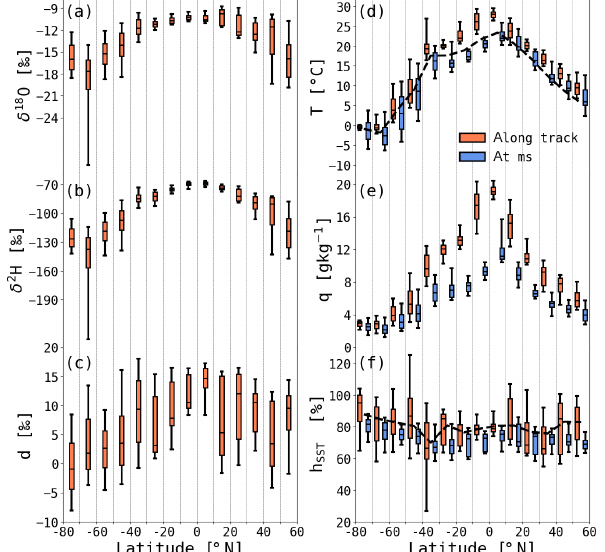
Figure 6. Box plots of meridional variations in SWIs and environ- mental variables for all legs showing the median (black horizontal line in box), interquartile range (boxes) and [5, 95] percentile range (whiskers) of variables in bins of 10 ◦ latitudinal width. (a) δ 18 O, (b) δ 2 H, (c) d , (d) air temperature ( T ), (e) specific humidity ( q ) and (f) the relative humidity with respect to sea surface tempera- ture ( h SST ) at the measurement location are shown. Additionally, for T , q and h SST , the weighted mean at the moisture sources (ms) is shown (d–f) . The dashed black lines show sea surface temper- ature from operational ECMWF analysis data (d) and the relative humidity at the measurement location (f) .